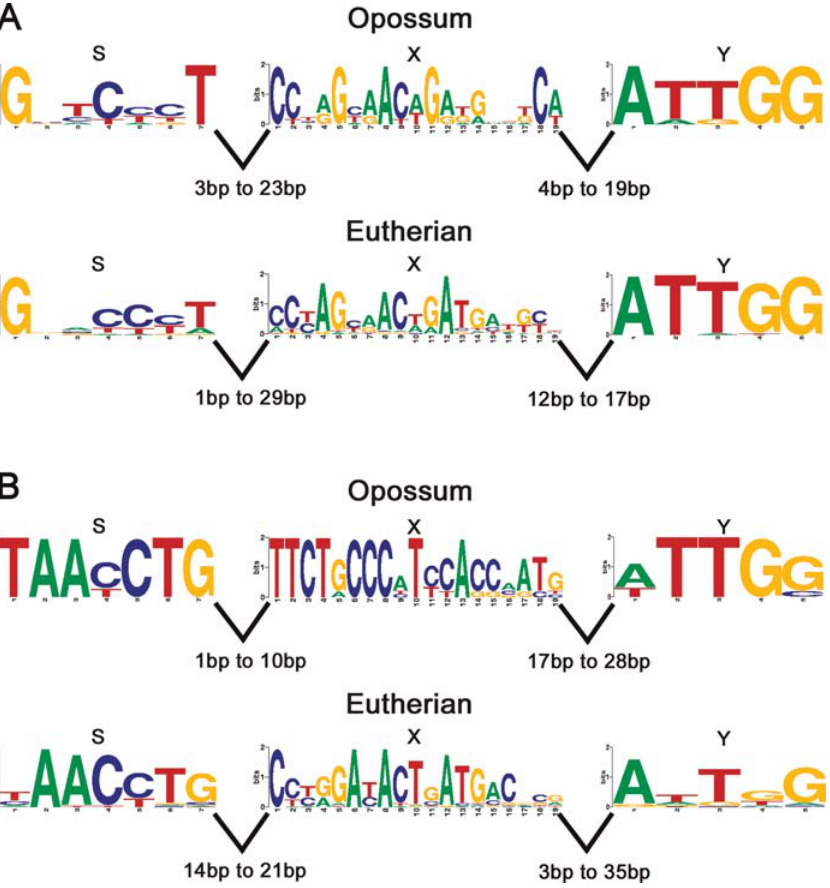
Figure 8. Analysis of the SXY Promoter Regions of MHC Class I and II Genes (A) SXY motifs in the MHC Class II genes. The LOGOs [48] of the corresponding position-specific scoring matrix models are presented. The height of each stack of symbols ( y -axis) represents the information content in each position of the DNA sequence in log 2 terms (bits of information) with a maximum value of 2. (B) SXY motifs in the MHC Class I genes. DOI: